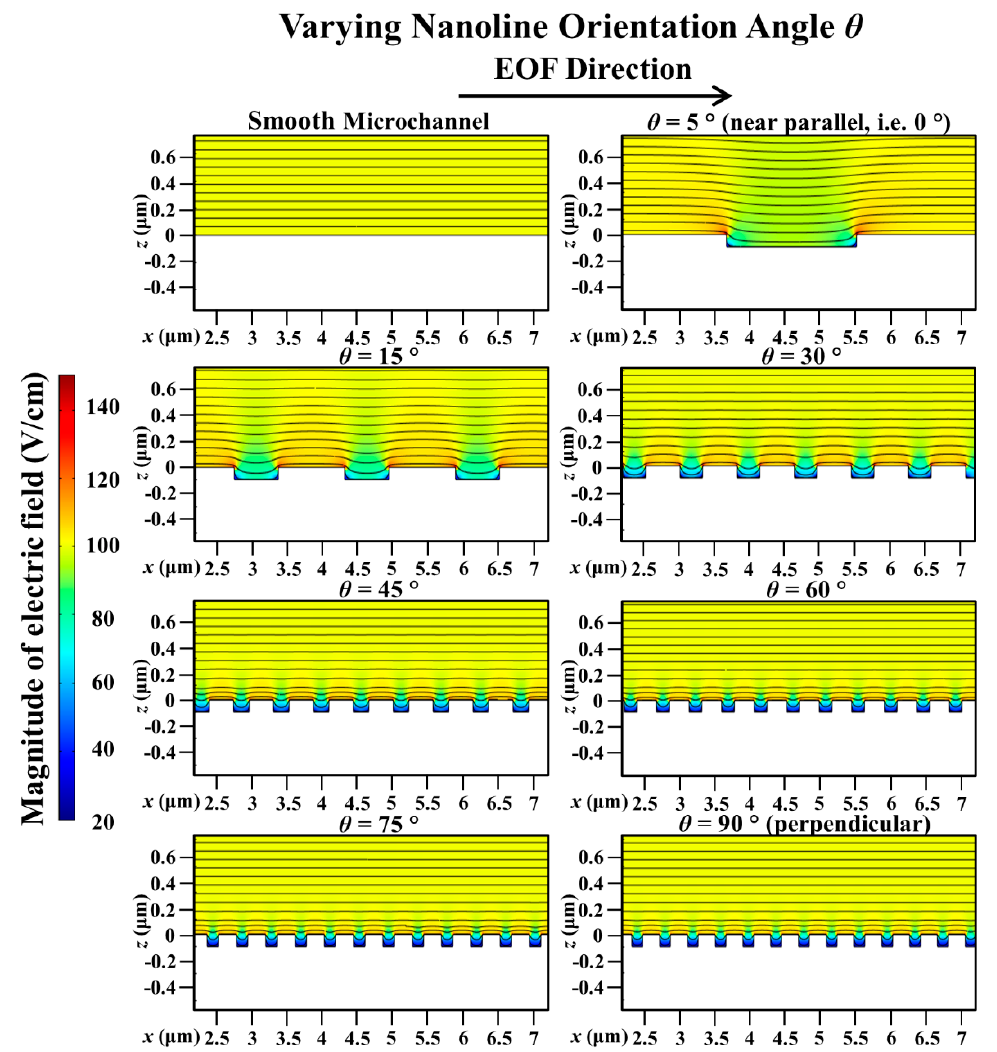
Figure 3. Simulated electric field distribution in microchannel with varying nanoline orientation angle θ , in comparison to smooth microchannel. Sodium bicarbonate (NaHCO 3 ) concentration was fixed at 1.0 mM, and nanoline width W , period P , and depth D were fixed at 160 nm, 400 nm, and 90 nm, respectively. When θ = 5°, distortion of electric field distribution is less severe. As θ increases, distortion increases due to increased number of apparent nanolines.